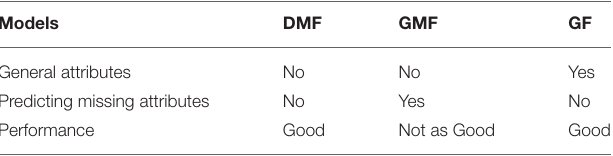
TABLE 12 | Comparison between three types of models. Models